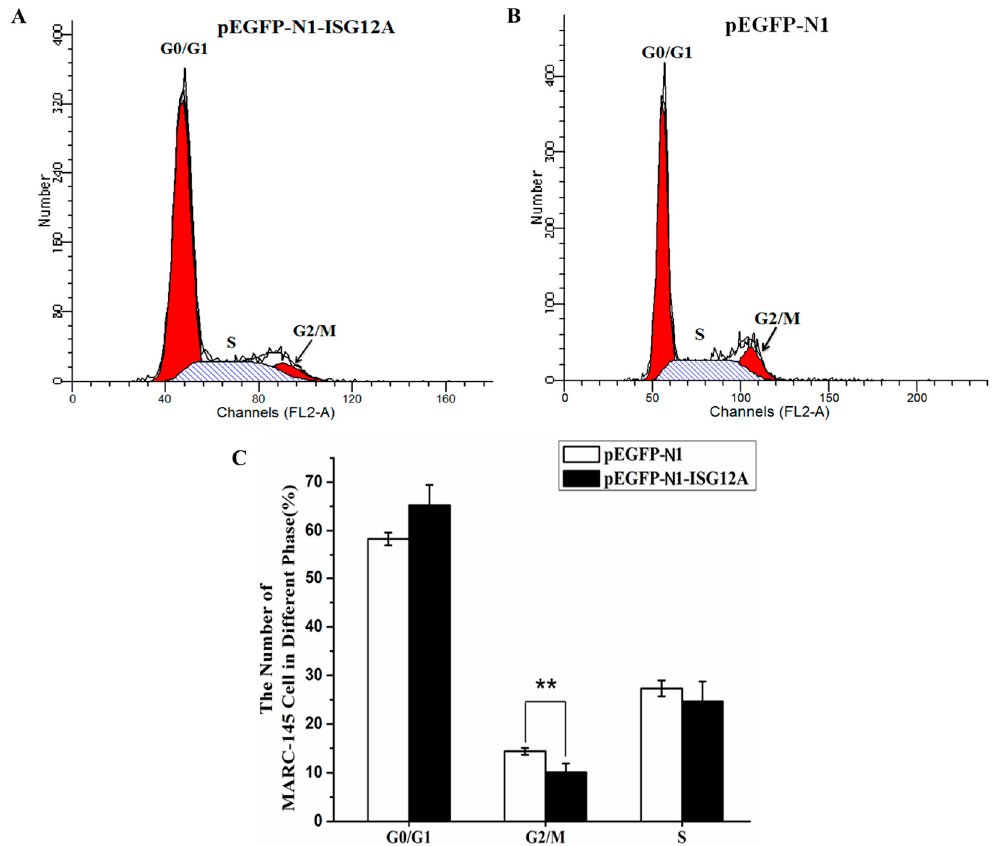
Figure 3. Porcine ISG12A influenced cell cycle. ( A ) DNA histogram measured by flow cytometry of the cells transfected with expression vector; ( B ) DNA histogram measured by flow cytometry of the cells transfected with control vector; ( C ) The statistical results of flow cytometry. G0/G1: first gap period; G2/M: second gap period; S: DNA synthesis and chromosome replication. Experiments were repeated three times. Student’s t -test: ** p < 0.01.